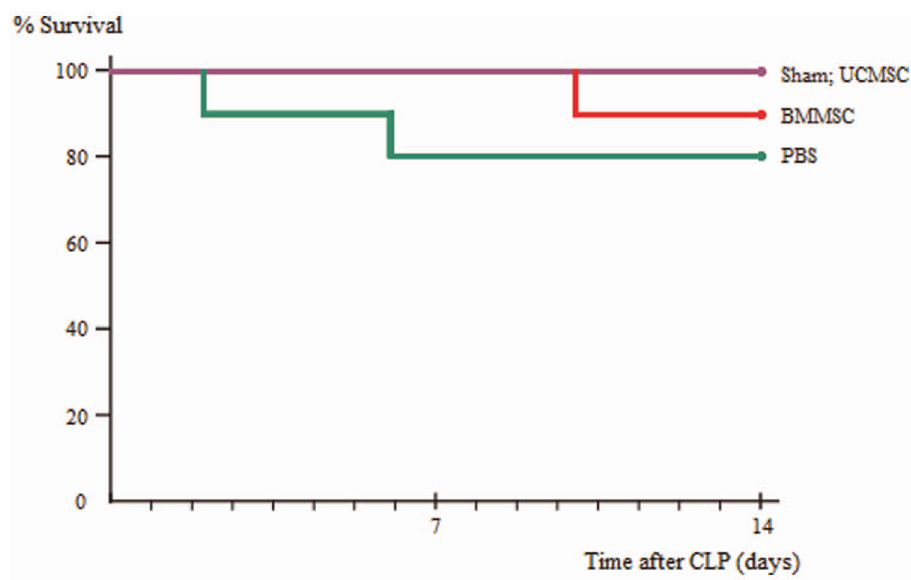
Figure 2. The beneficial effects from MSC administration on survival in rats with CLP-induced sepsis. Survival was evaluated for 14 days. Although no statistical significance, it appeared that rats receiving UCMSCs or BMMSCs after CLP had lower mortality rates than rats receiving PBS only after CLP. n=10 rats/group.